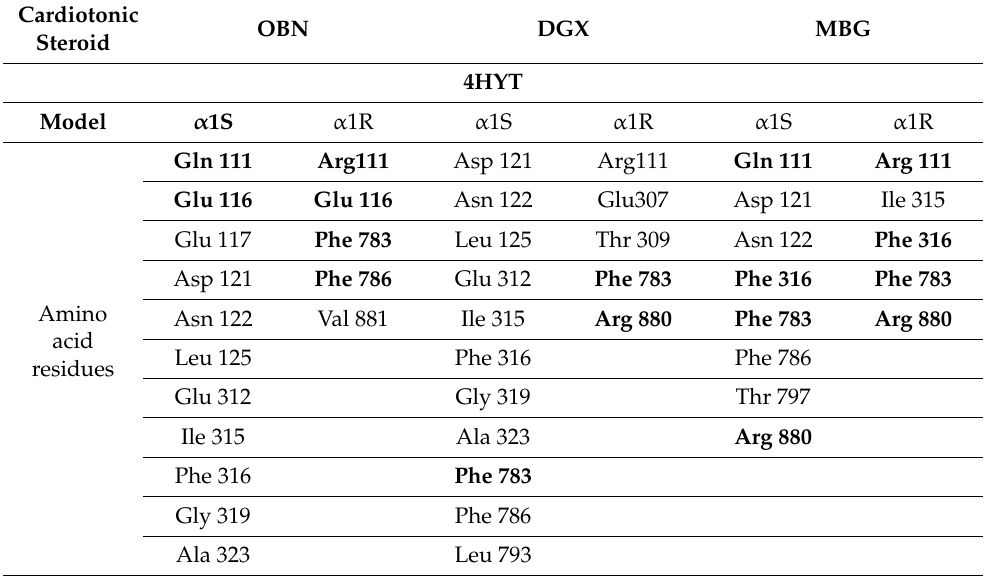
Table 4. Amino acid residues of α 1S- and α 1R-NaK-ATPase involved in the interaction with different cardiotonic